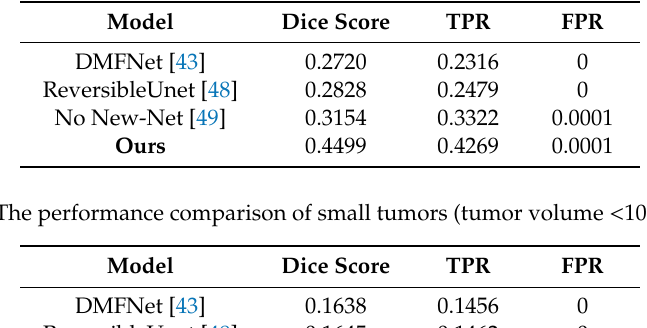
Table 1. The performance comparison of small tumors (tumor volume < 2000 voxels).